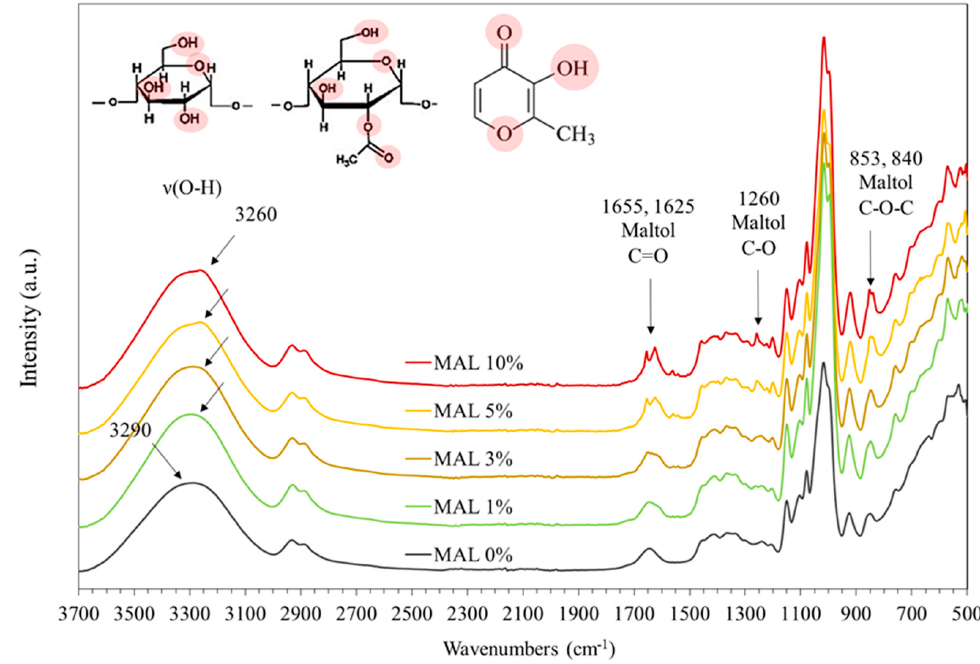
Figure 2. FTIR absorption spectra of starch films containing maltol (MAL) at 0, 1, 3, 5 and